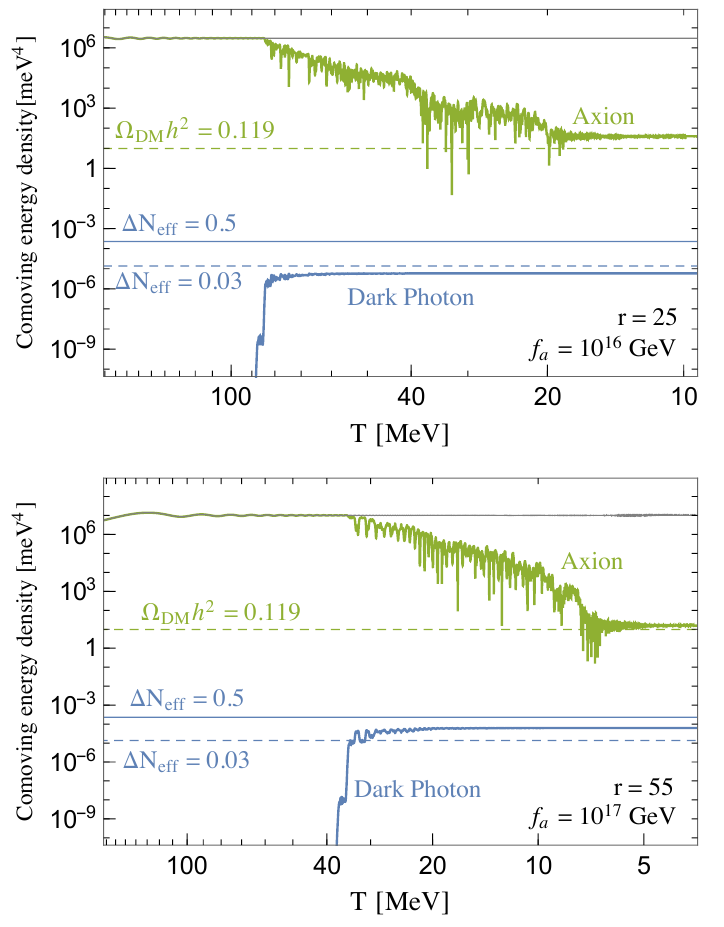
Figure 2 . Comoving energy densities of the axion ( (cid:26) a a 3 , green) and the dark photon ( (cid:26) d a 4 , blue) as a function of the temperature, with a = 1 today, for two example values of f a and r . We also show the evolution of axion energy density in the absence of our mechanism (gray). The green dashed line indicates the correct dark matter abundance, and the blue horizontal lines indicate the current (solid) and future (dashed) sensitivity to the dark photon contribution to (cid:1) N e(cid:11) . The absolute value of the axion and the dark photon energy densities are comparable at the point in which the axion energy density starts departing from the usual QCD axion behavior. The initial misalignment was chosen to be (cid:18) i =